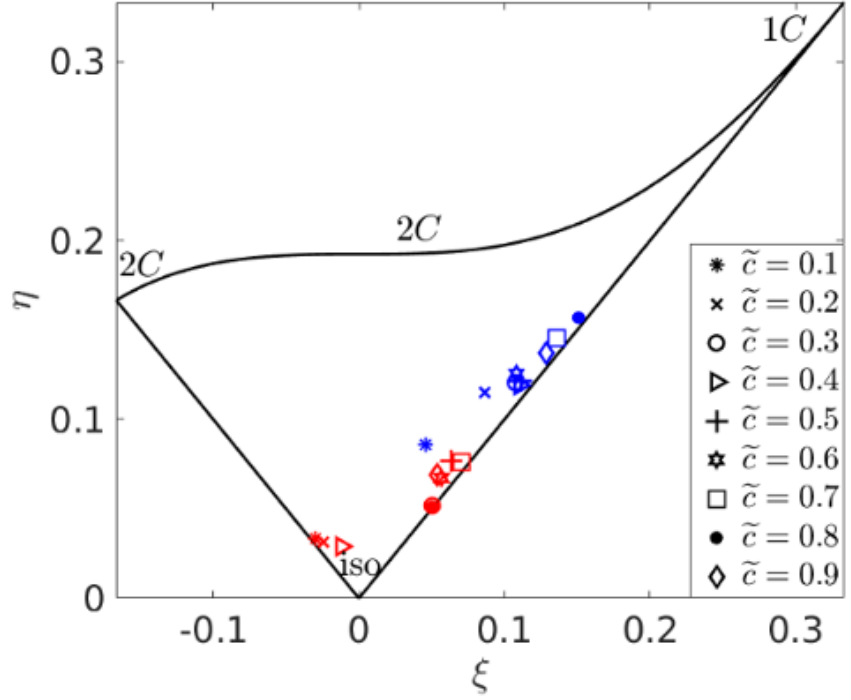
Figure 7. Lumley triangle on the plane of the invariants ξ and η of the Reynolds stress anisotropy tensor for case A (blue) and E (red) for different values of c . 1 C , 2 C and iso are the one component limit, two component limit and isotropic